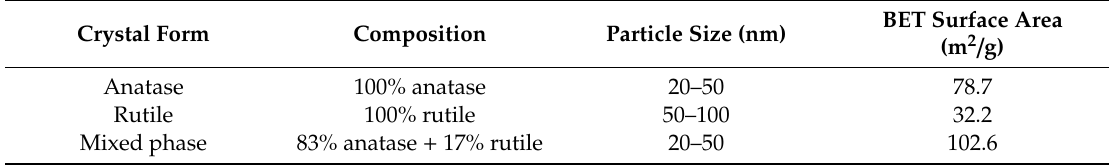
Table 3. Characteristics of nano-TiO 2